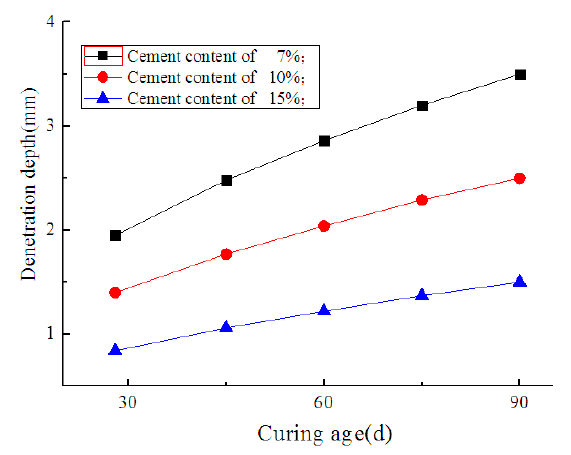
Figure 6. Variation curves of deterioration depth with curing age.